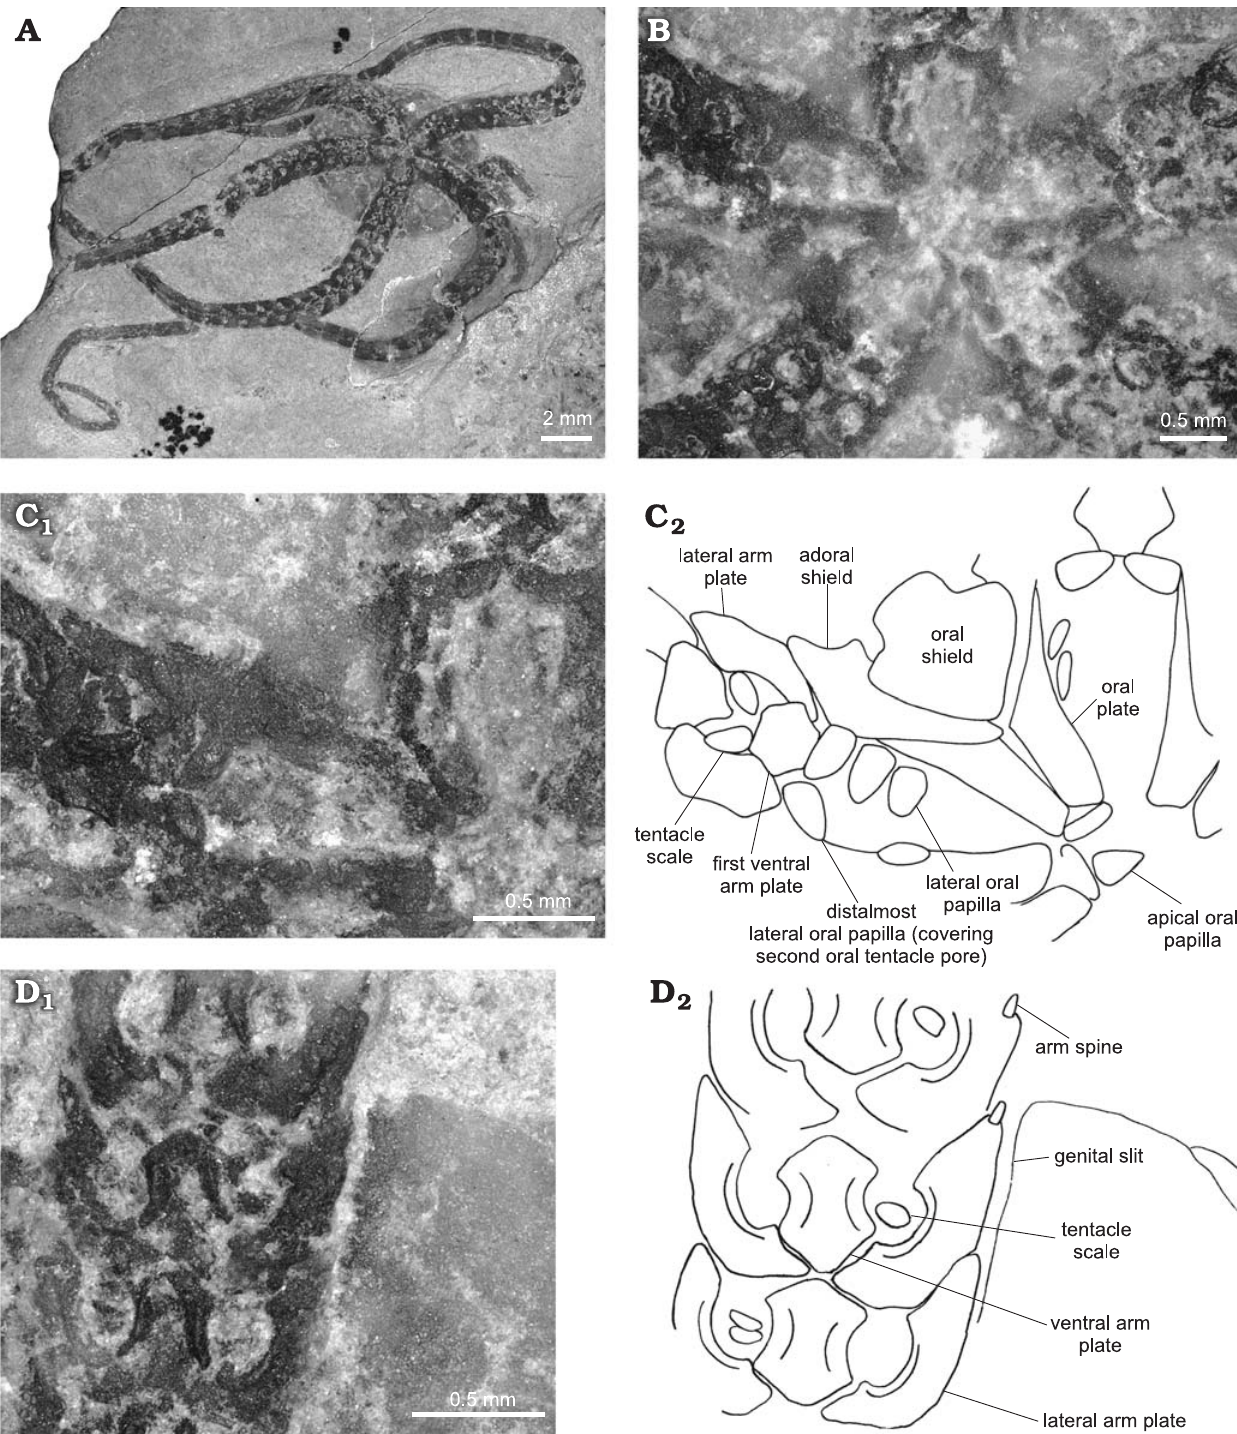
Fig. 2. Ophiurin brittle star Aganaster jagiellonicus sp. nov. from the upper Tournaisian to lower Visean (lower Carboniferous) Mazurowe Do ł y Formation, Rudawa Group of Czatkowice quarry, D ę bnik Massif, southern Poland; MZUJ T/0282, holotype. A . General view of the specimen, exposing the ventral side (also illustrated by O’Hara et al. 2014). B . Oral skeleton. C . Detail of the oral skeleton; photograph (C 1 ), interpretative drawing (C 2 ). D . Detail of basal arm segments; photograph (D 1 ), interpretative drawing (D 2 from beside the second arm segment to the edge of the disc; tal end; madreporite indiscernible; adoral shields long and oral shield slightly shorter than one fourth of the disc radius, slender, extending around the lateral edge of the oral shield arrow-head shaped with pointed to almost right proximal and separating it from the lateral arm plates of the first arm angle, deeply incised latero-distal edges and rectangular dis- segment, proximal tips of adoral shields meeting in front of